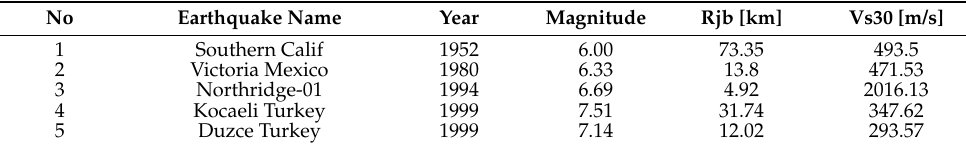
Table 3. Ground motion records. Figure 5. Target, mean, and individual response spectra of the matched ground motions: ( a ) H1; ( b ) H2; ( c ) V.